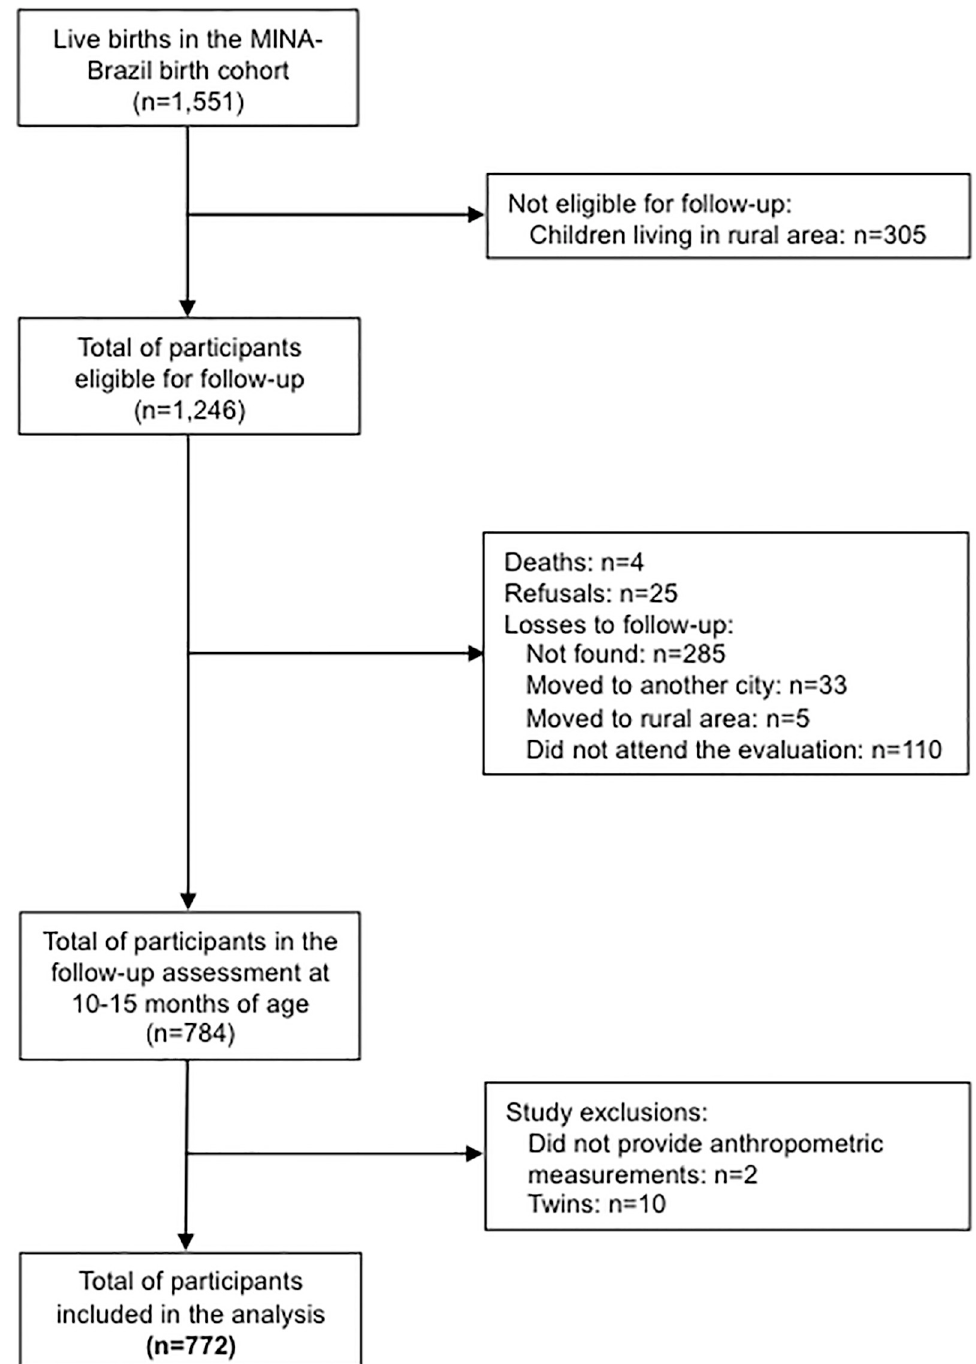
Fig 1. Flowchart of participants in the MINA-Brazil Study for analysis of linear growth and weight attained at 10–15 months of age, Cruzeiro do Sul, Acre, Brazil.